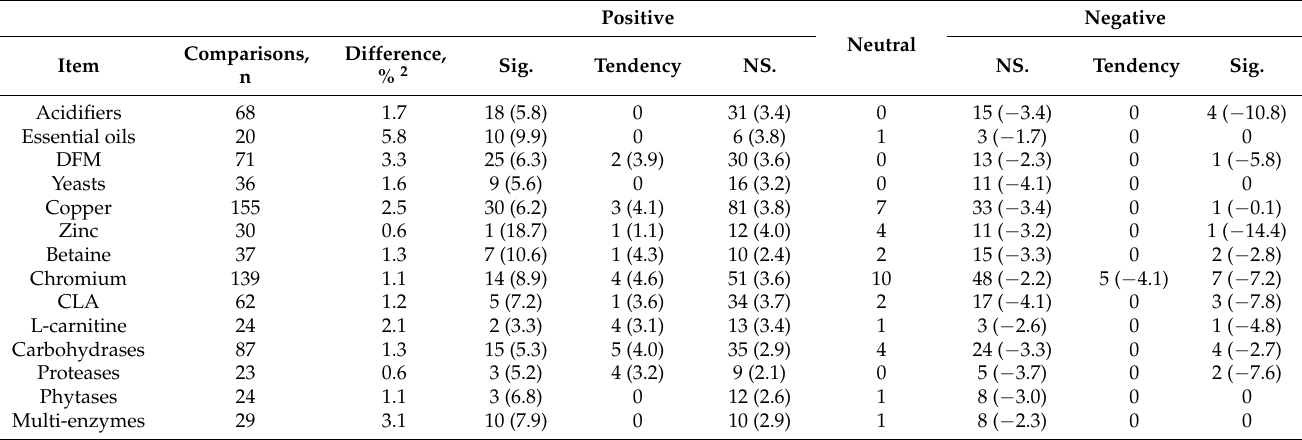
Table 1. Summary of the effects of feed additives on grow–finish pig ADG 1,3 .